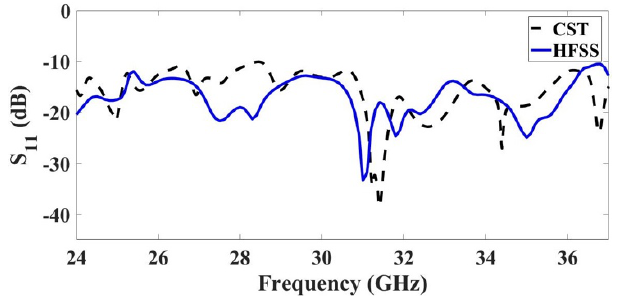
FIGURE 5. Simulated reflection coefficient of the proposed antenna as obtained through both CST and HFSS